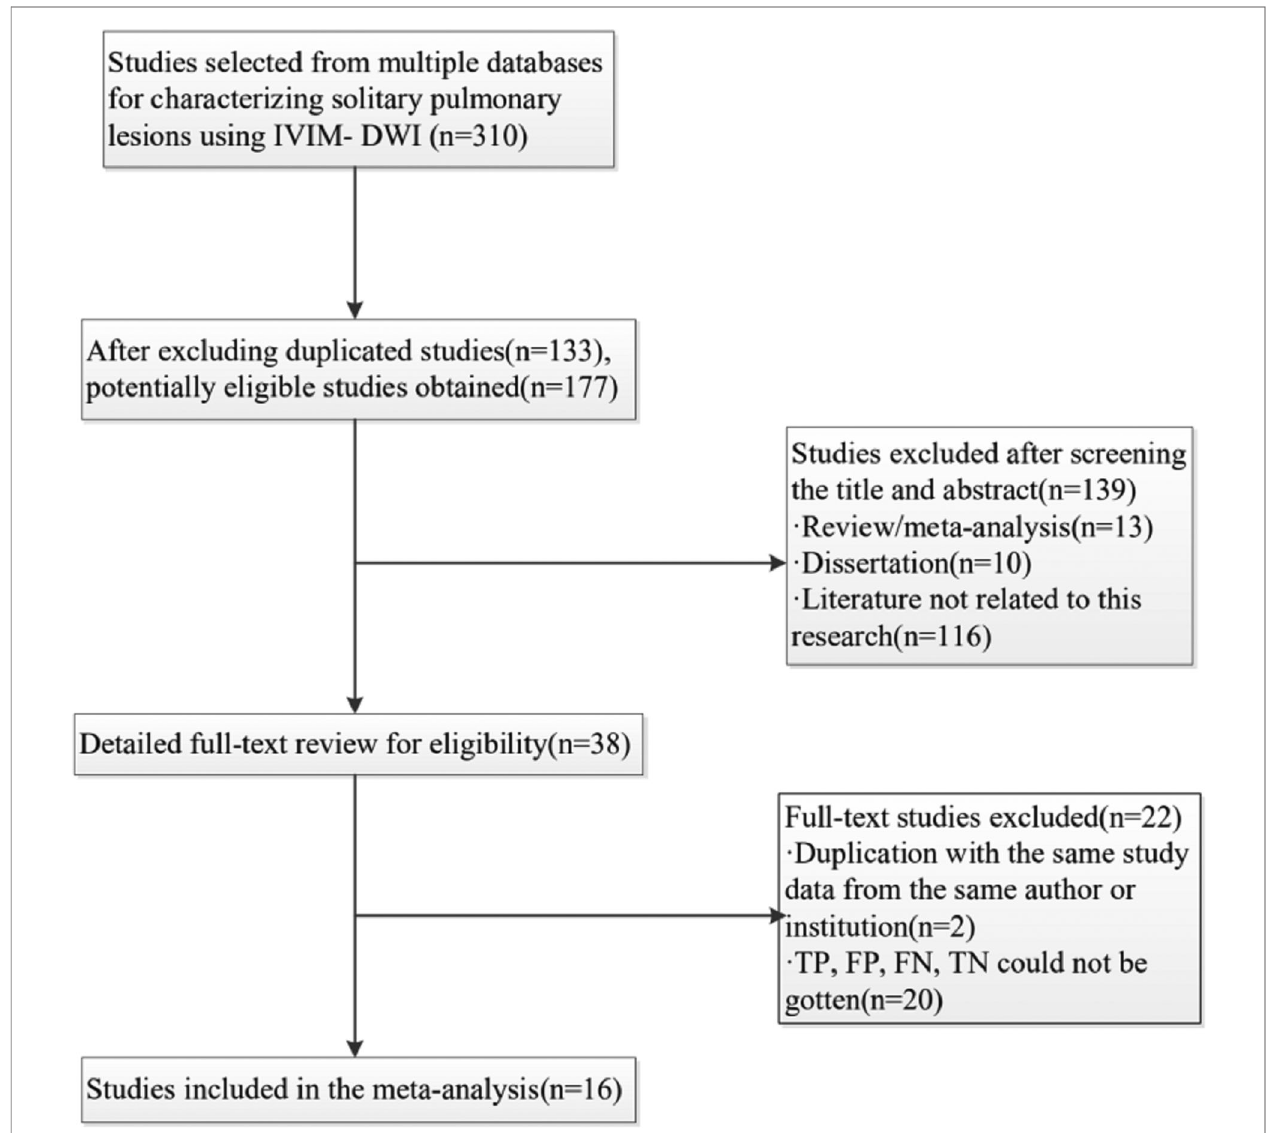
FIGURE 1 | Flowchart detailing the study selection process. Sixteen studies that met the inclusion criteria were fi nally included. FN, false negative; FP, false positive; TN, true negative; TP, true